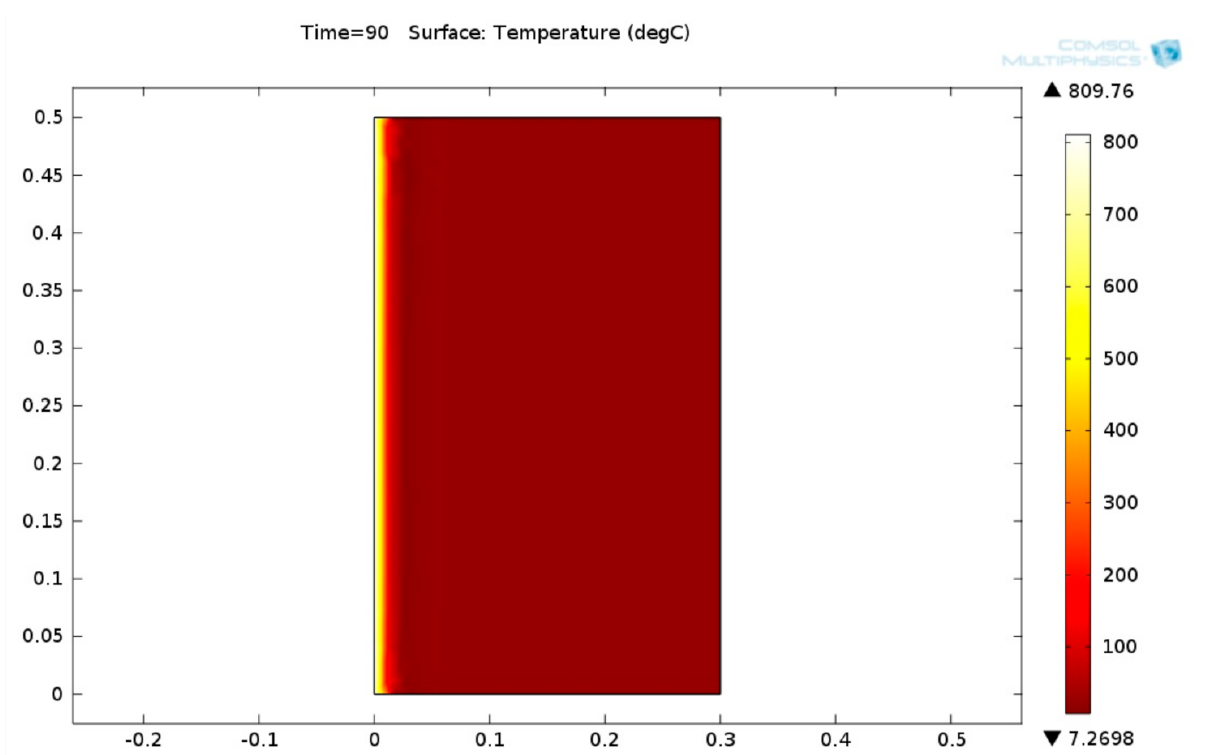
Figure 17. 2D plot of the fiber-reinforced carbonate aggregate concrete lining temperature field.